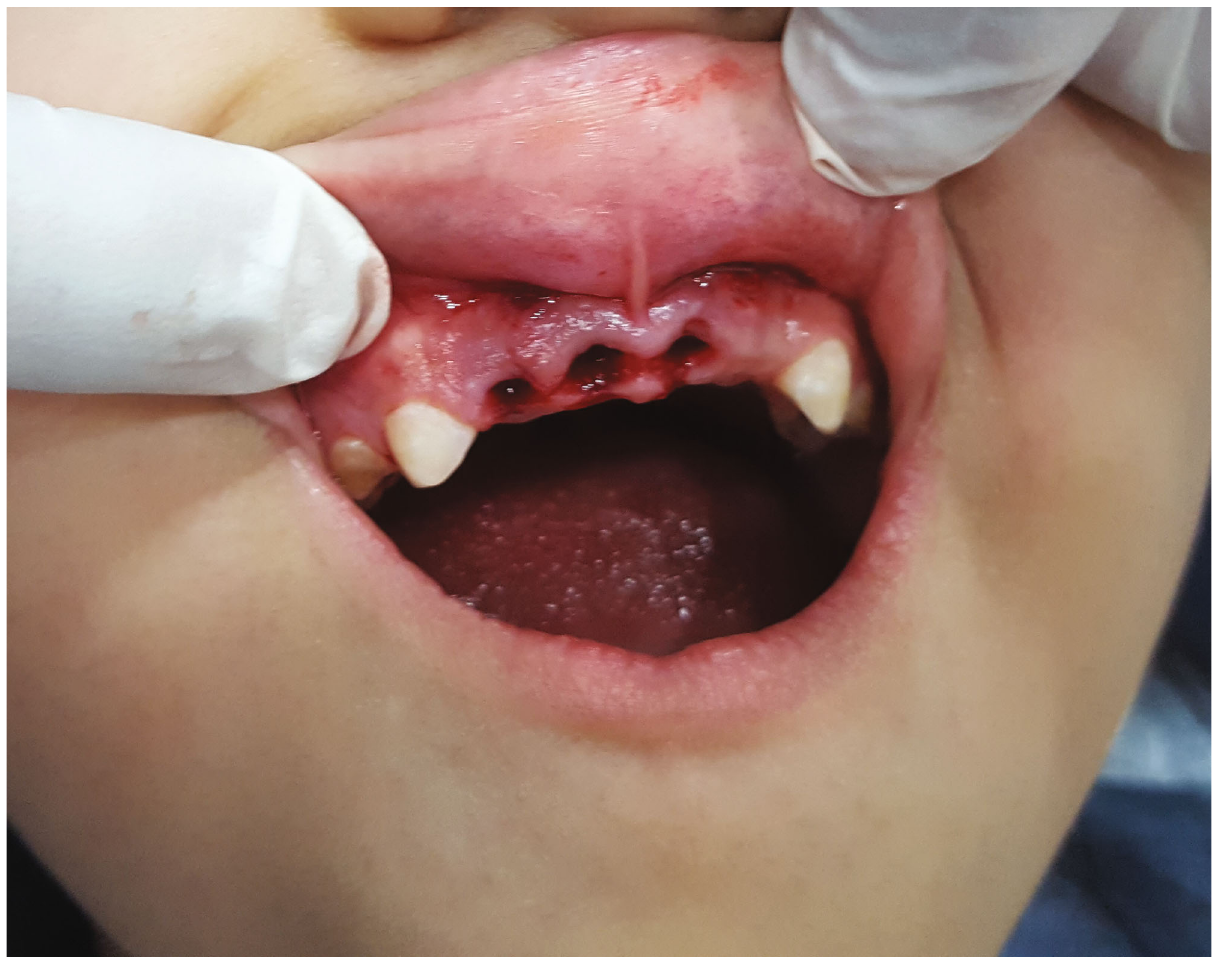
Figure 5: Extraction of primary anterior